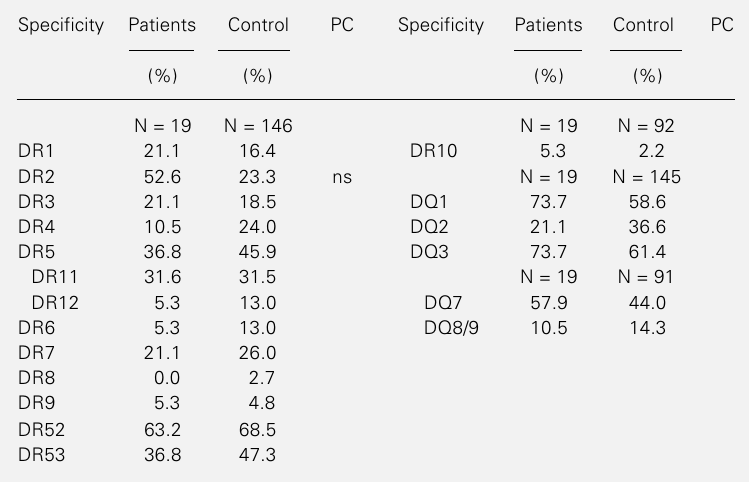
Table 4 - HLA-DR and DQ antigen frequencies in patients with the D form of leprosy and in the control group. ns = Nonsignificant (indicated only if P<0.05 before correction); P = probability; PC = corrected probability (Chi-square test). Specificity Patients